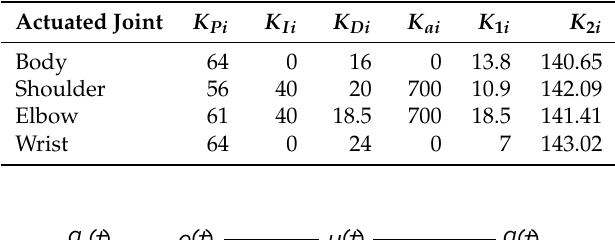
Table 3. Gains of the PID controllers and state observers.